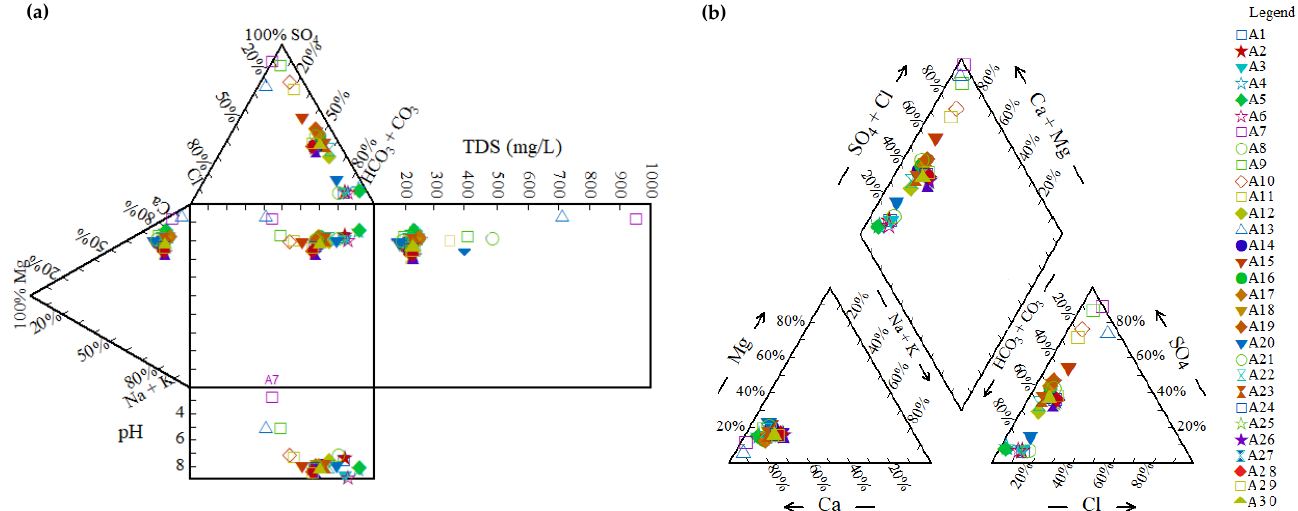
Figure 6. Durov ( a ) and Piper ( b ) diagrams describing the water facies of the studied surfacewaters. The overall characteristics of the chemistry in the surface water samples, according to the Piper diagram, are the dominance of the alkaline earth elements (Ca and Mg) over the alkaline elements (Na and K) and for the weak acids (HCO 3 − ) over the strong acids (SO 42 − + Cl − ). The Piper and Durov diagrams showed that the water samples were divided into two main types: Mg-HCO 3 − type (A1–A6, A8, A12, A14, A16–A30), indicating their carbonate- dominant lithology and Ca-Cl − type (A7, A9, A10, A11, A13, A15). The Durov plot also indicated that the majority of samples are alkaline, except for A7, A9 and A13, which were characterized by low pH